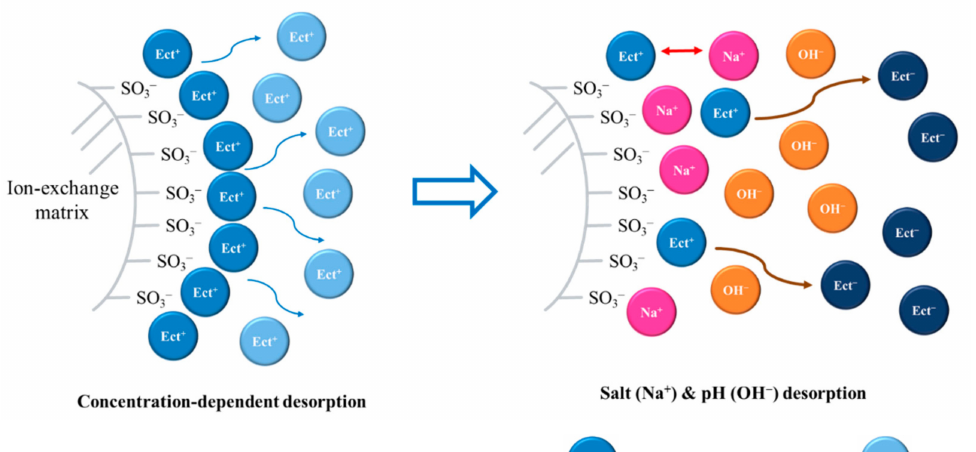
Figure 13. Mechanism of ectoine desorption using Dowex ® HCR-S. : adsorbed ectoine ion , : free ectoine ion , : sodium ion , : hydroxide ion